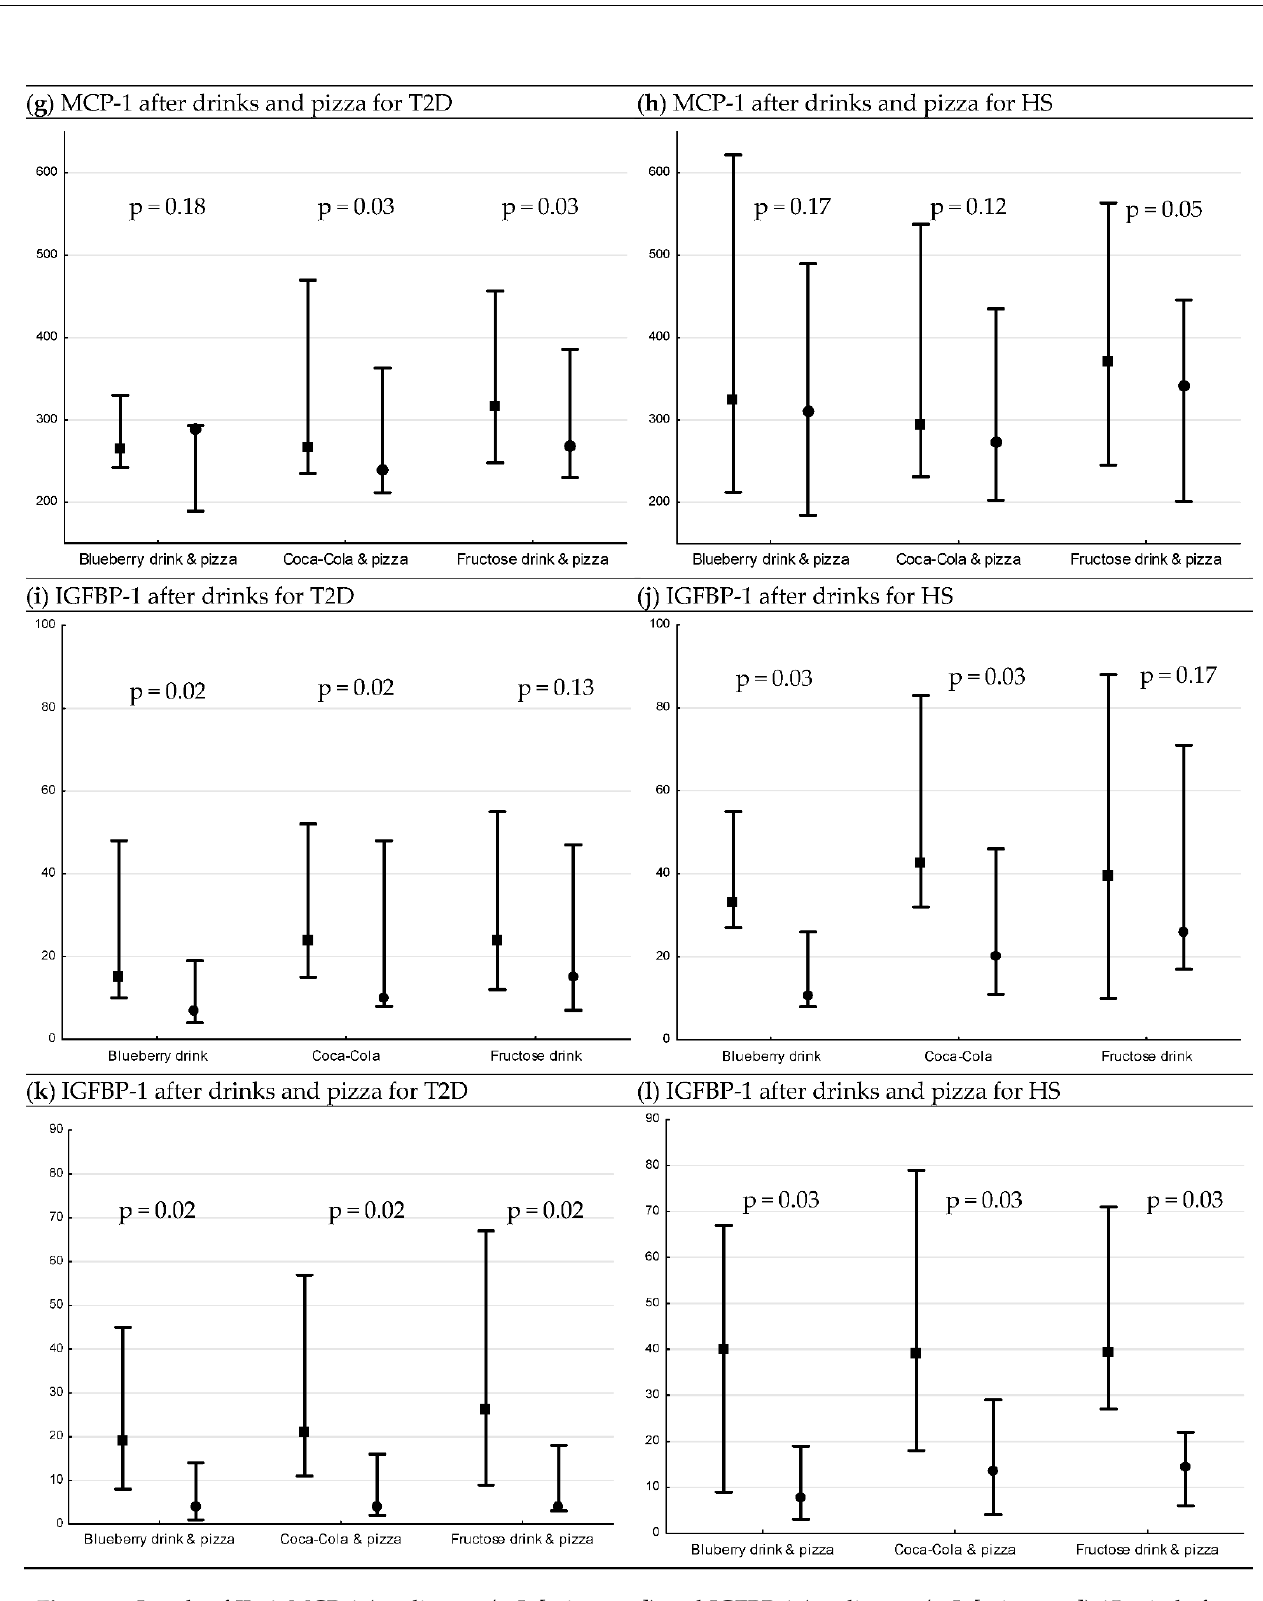
Figure 2. Levels of IL-6, MCP-1 (median pg/mL [min, max]) and IGFBP-1 (median µg/mL [min, max]) 15 min before interventions, and 120 min after drink interventions and 240 min after drink + pizza interventions *. Baseline and endpoint levels of serum IL-6, MCP-1 and IGFBP-1, respectively. p -values for Wilcoxon matched pairs test. Square= − 15 min, circle = 120 min/240 min, respectively. ( a ) serum IL-6 levels before and after drink interventions in T2D, ( b ) serum IL-6 levels before and after drink interventions in HS, ( c ) serum IL-6 levels before and after drink + pizza interventions in T2D, ( d ) serum